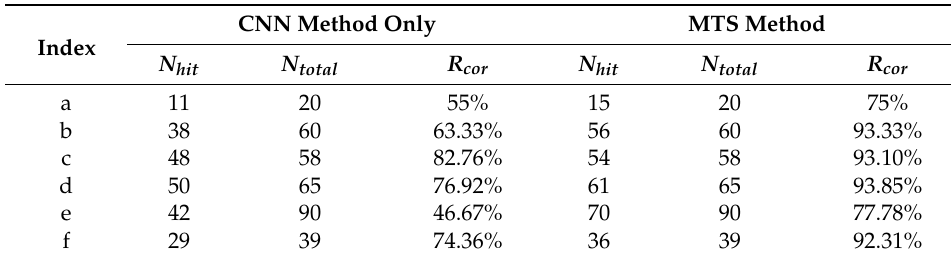
Table 3. Recognition results for the other states.